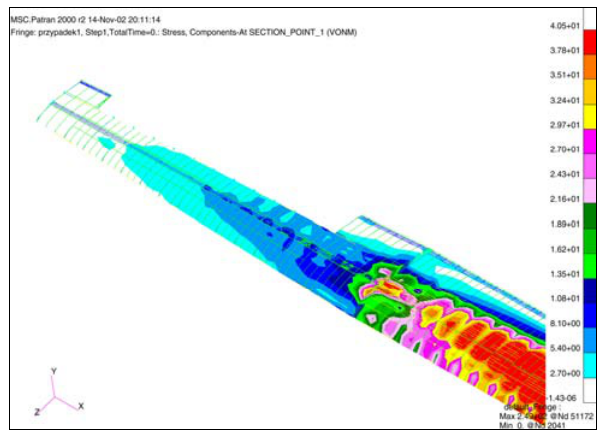
Fig 10. Effective stress concentration (von Misses) around wingtip and centre wing connection